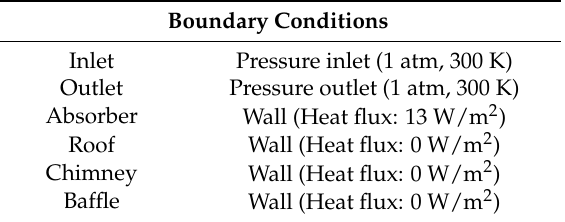
Table 2. The boundary conditions of SUT: All walls except for the absorber are